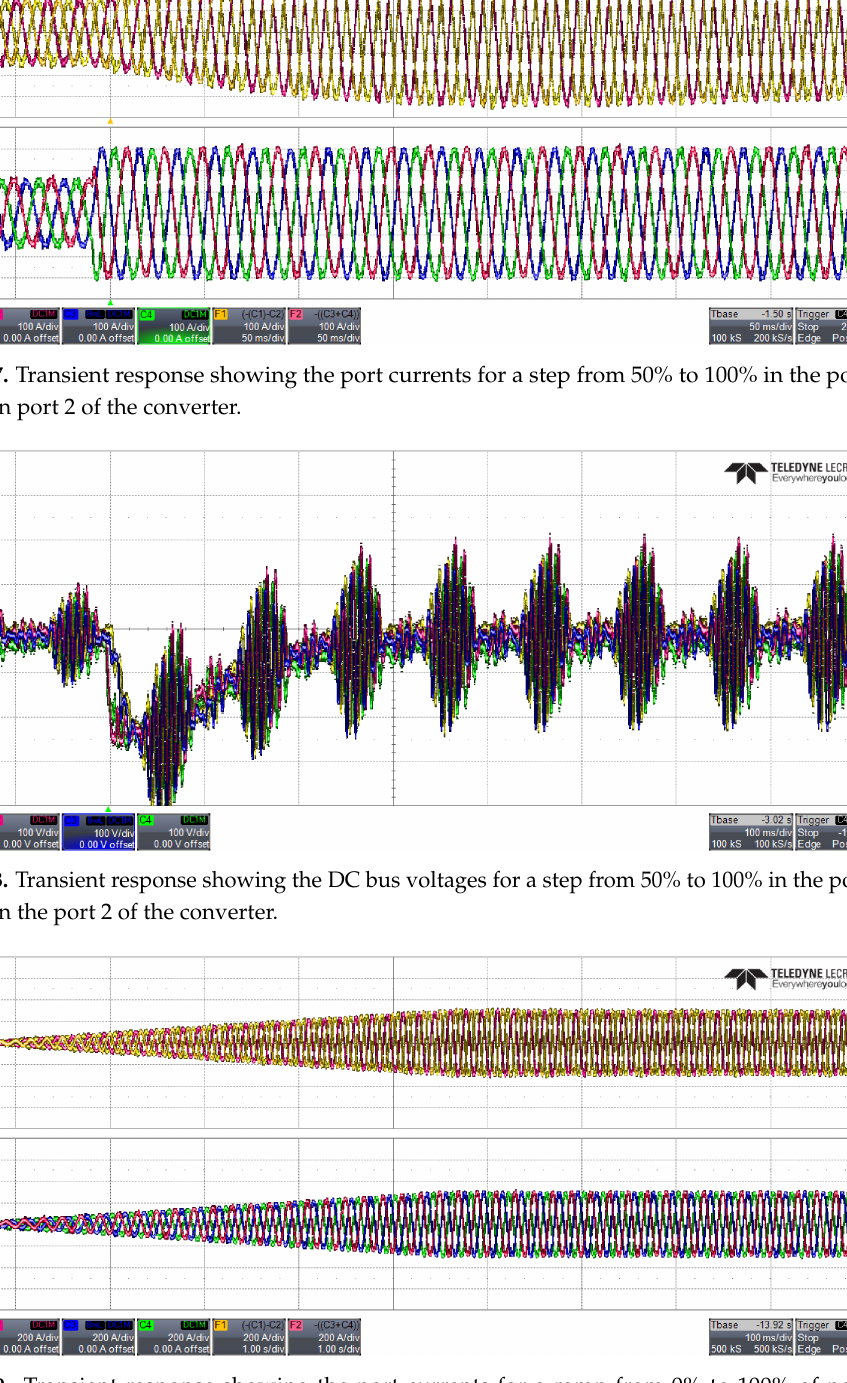
Figure 19. Transient response showing the port currents for a ramp from 0% to 100% of power injected into port 2 of the converter. The DC bus voltages for the ramp transient response are presented in Figure